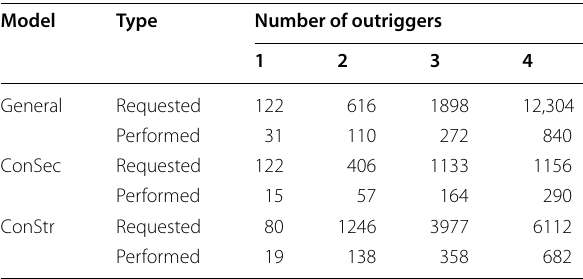
Table 4 Number of FEA requested and performed for the divided-area